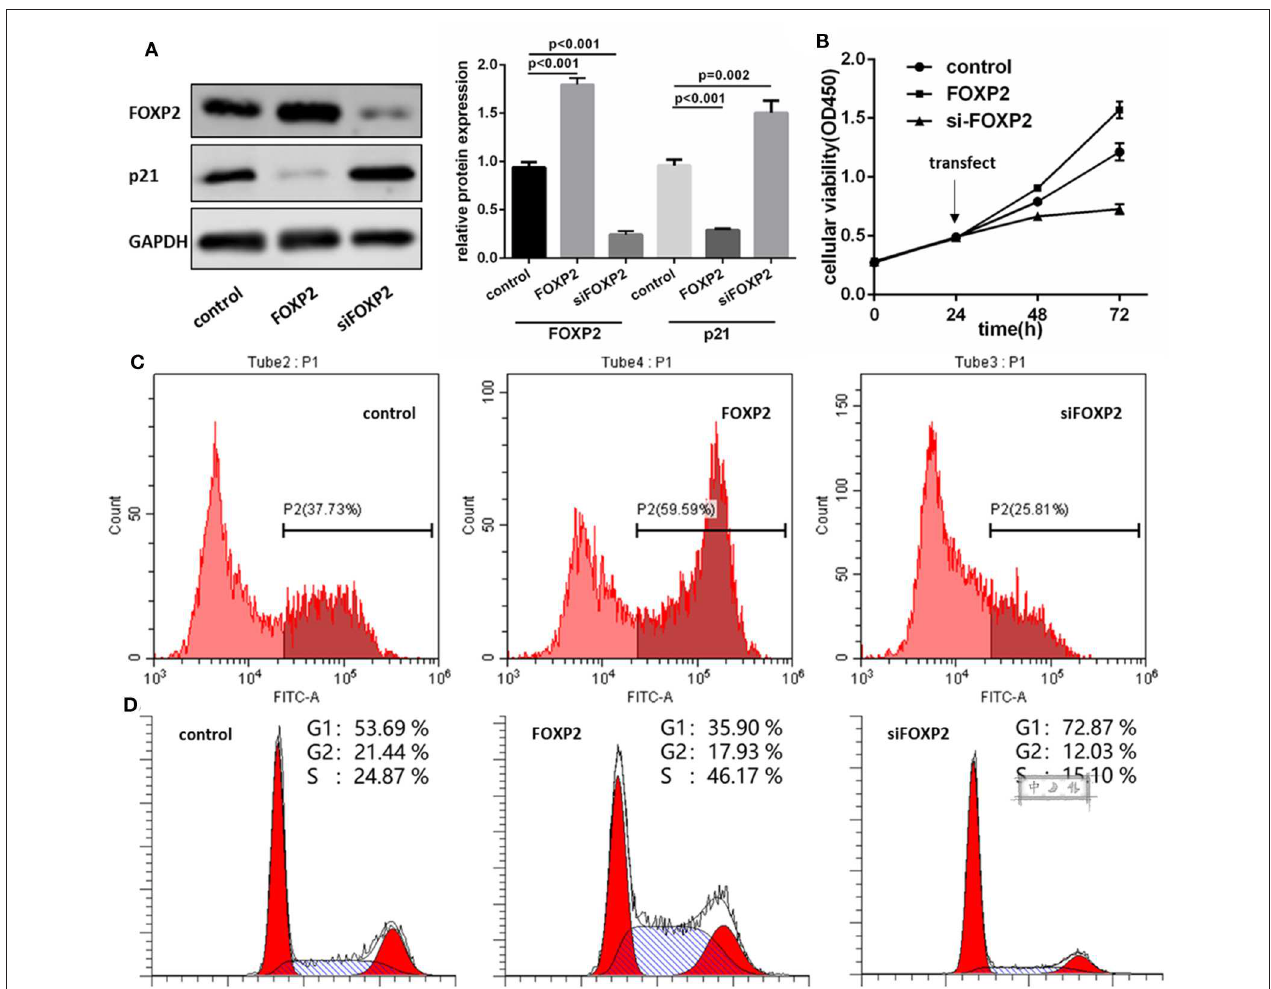
FIGURE 3 | FOXP2 is a positive regulator of U87MG cell proliferation. (A) pcDNA3.1-FOXP2 and siRNA transfection is used to regulate the FOXP2 expression in U251 cell. Western blot shows that FOXP2 expresses as expected ( p < 0.001). Upregulated FOXP2 leads to low expression of p21 ( p < 0.001) and down regulated FOXP2 leads to high expression of p21 ( p = 0.002). (B,C) CCK-8 (B) and EdU (C) shows high expression of FOXP2 contributes to cell proliferation while low expression leads to the opposite effect. (D) Cell cycle is arrested in cells with low expression of miR-9-5p analyzed by Flow